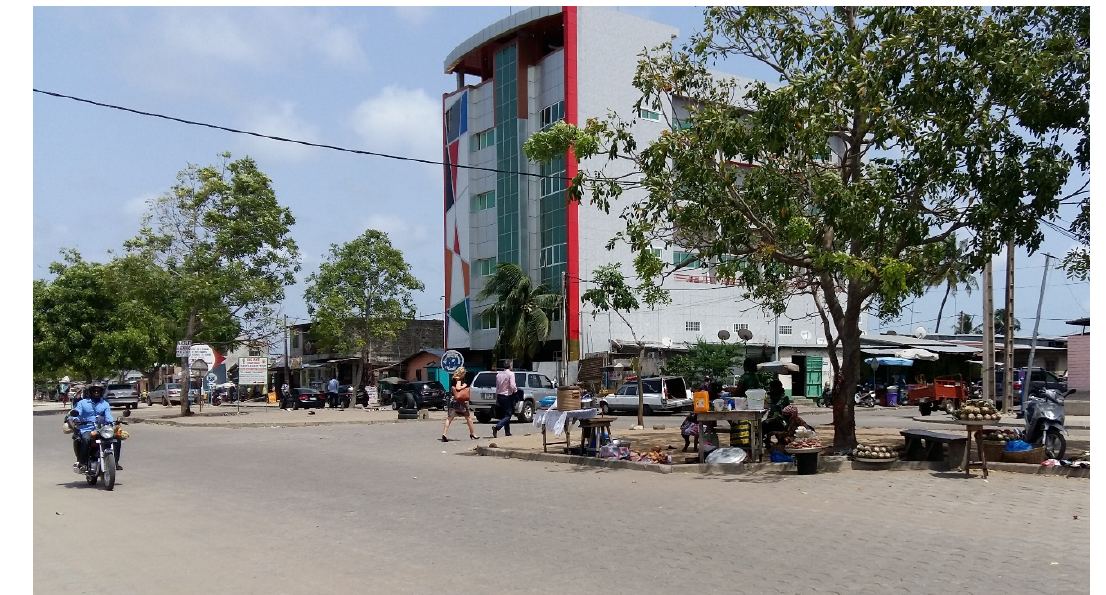
Figure 1. Head office of l’Agence Nationale du Domaine et du Foncier in Cotonou.